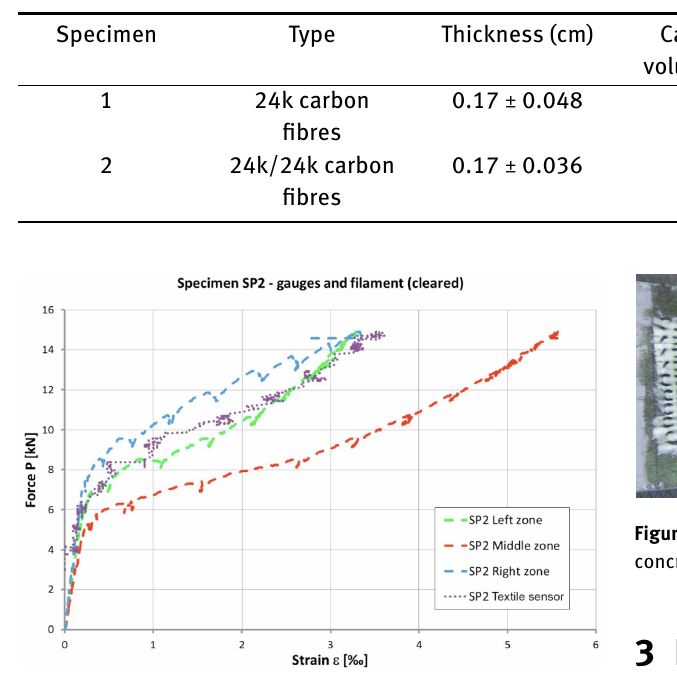
Figure 2: Strain-Load relationships for specimen SP2.